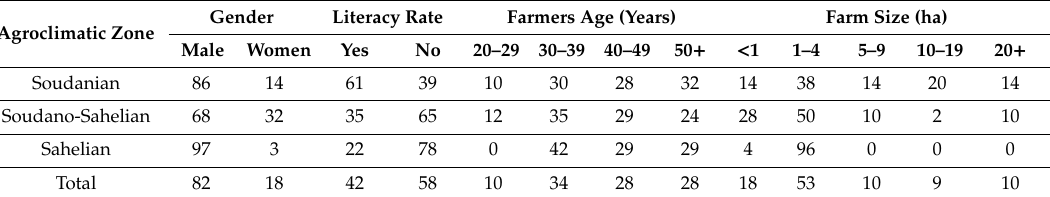
Table 2. Socio-economic characteristics of farmers surveyed and farm typology (as % of respondents) across the di ff erent agroclimatic